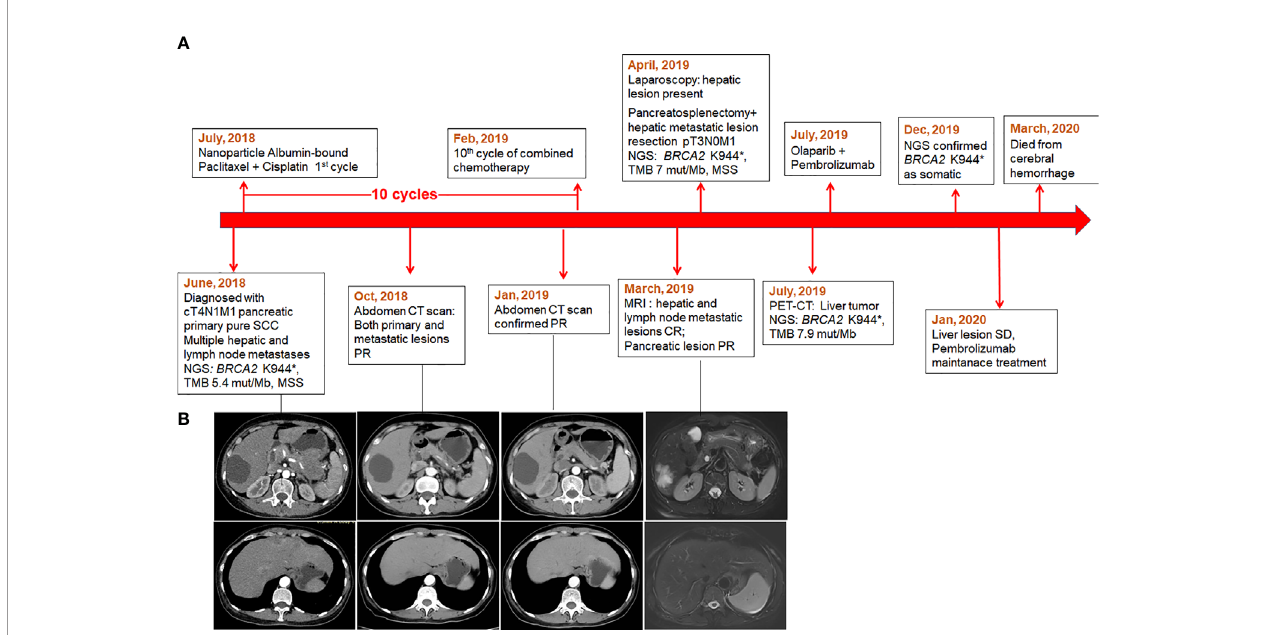
FIGURE 1 | The timeline of patient ’ s treatment history and the response of the tumor lesions. (A) Time line; (B) The radiographic imaging of pancreatic and metastatic liver